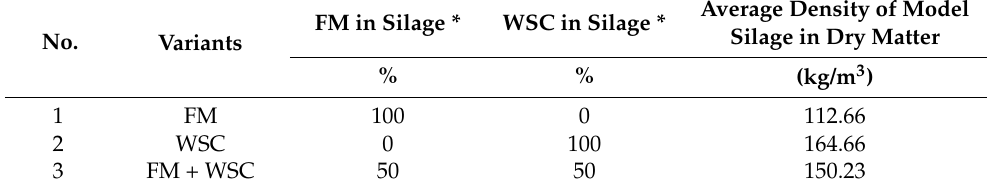
Legend to Table 2: * Percentage w/w ; FM—fodder mallow; WSC—white sweet clover. The method of microsilage production was identical for all three variants: 8 kg of chopped material was placed in a mini silo (container with a diameter of 150 mm and a height of 1000 mm), together with the inoculant for each silo (Silo Solve EF, Chr. Hansen Holding Ltd., Starovice, Czech Republic), dosed at 5 g + 3.5 l H 2 O/t. This